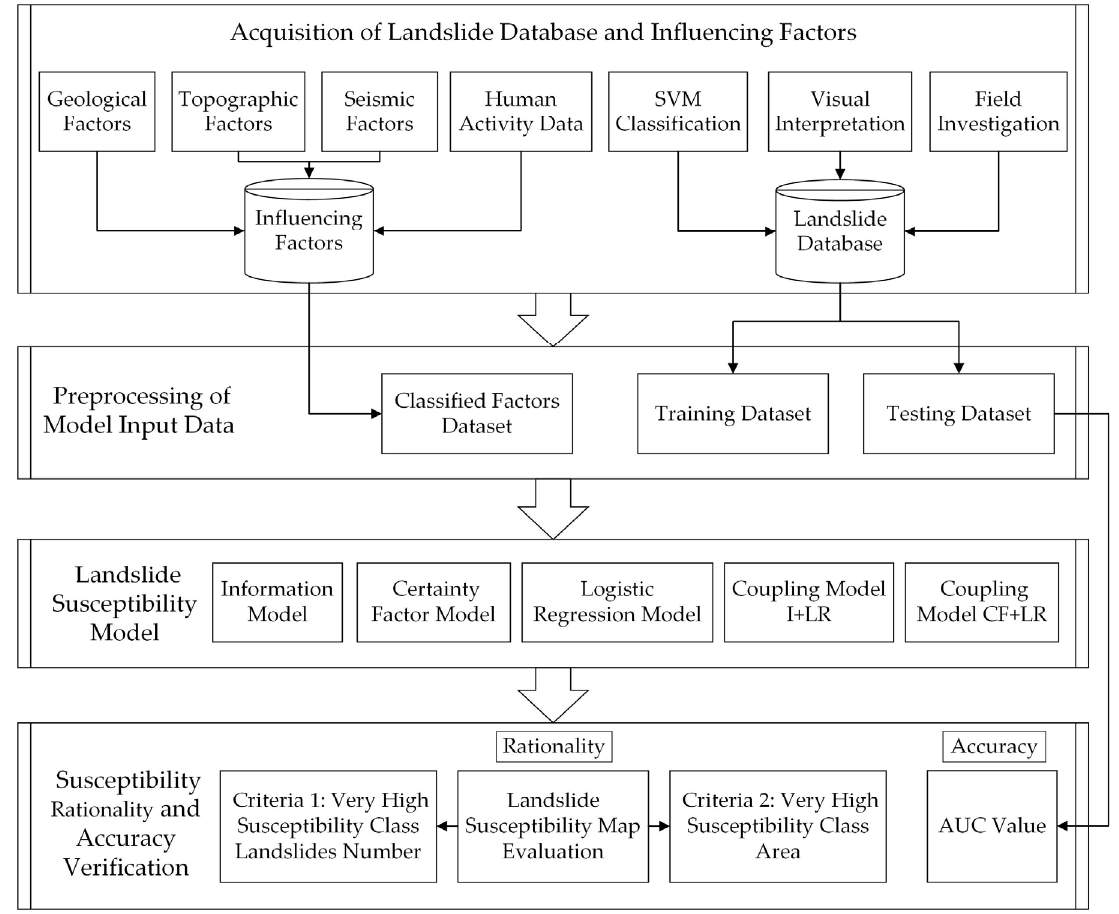
Figure 2. Procedural flow chart of this study.